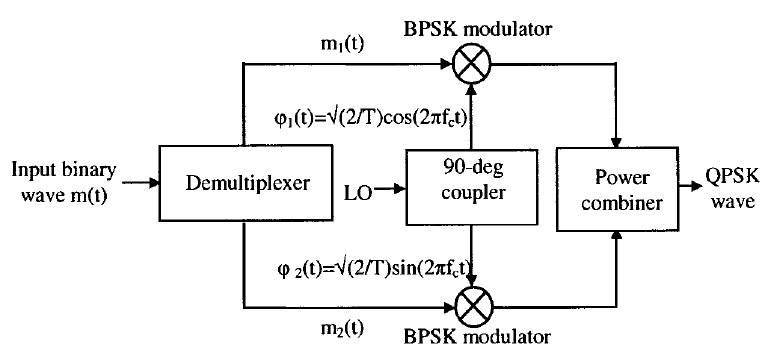
FIGURE 2 Block diagram for a